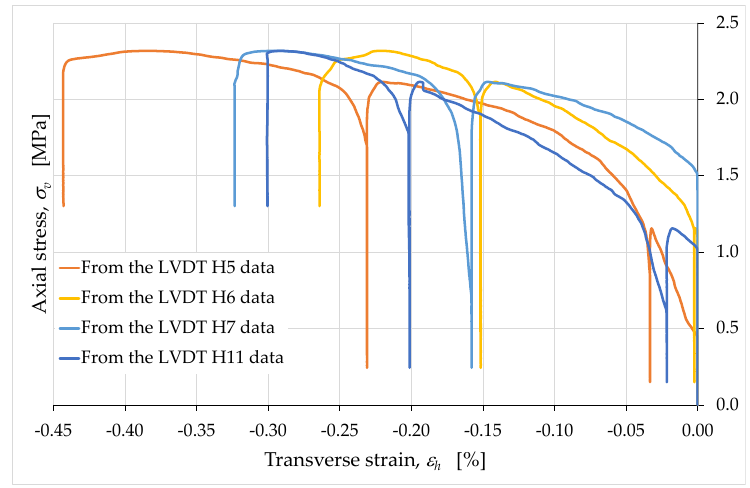
Figure 15. Axial stress/transverse strain curves acquired by the horizontal LVDTs between the ribs.